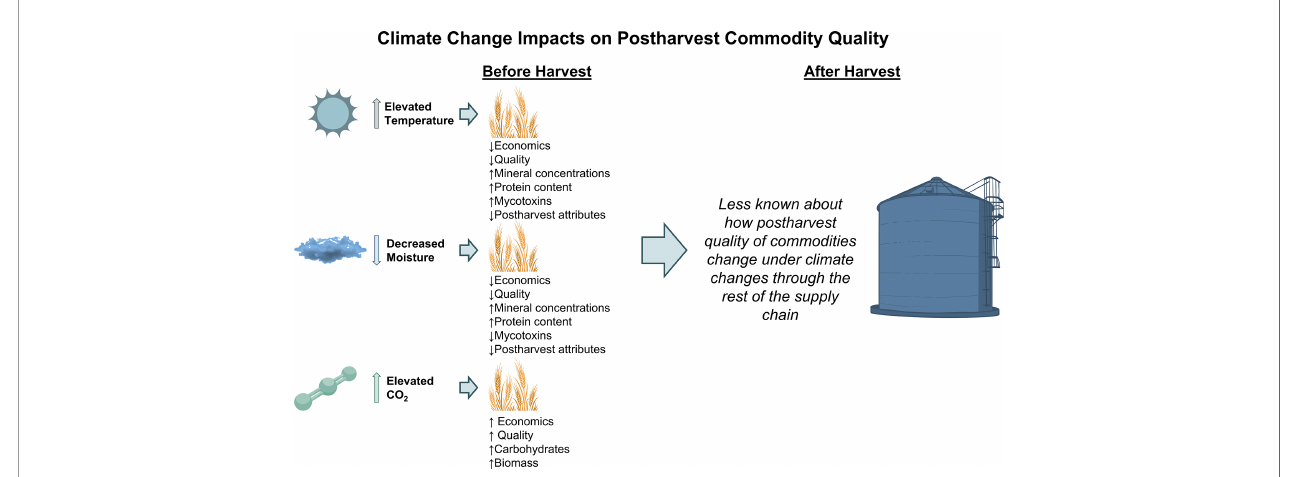
FIGURE 1 | Climate change impacts (e.g. elevated temperature, changed moisture, elevated CO 2 ) on postharvest commodity quality starting prior to harvest and continuing throughout the supply chain. Less is known about how commodity quality is affected after harvest compared to prior to